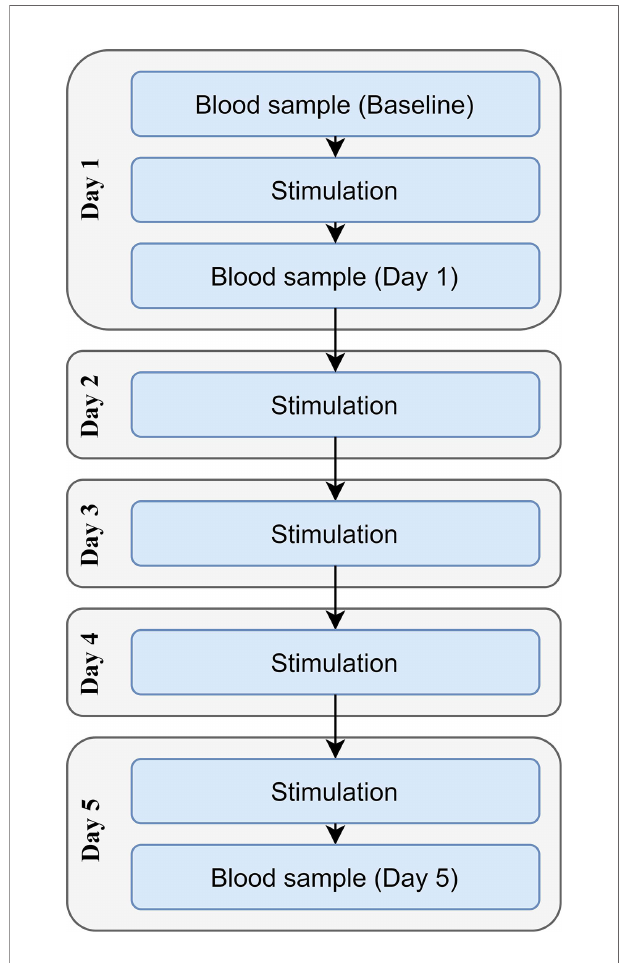
FIGURE 1 | Timeline of the